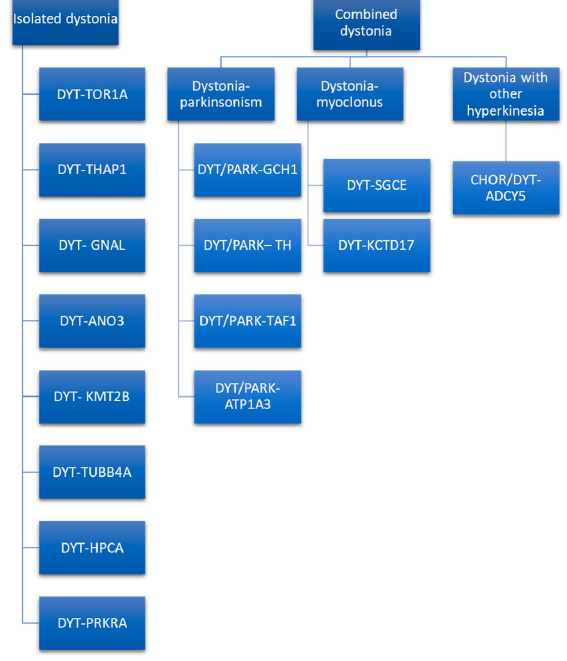
Figure 2. Isolated and combined genetic forms of dystonia [69] .